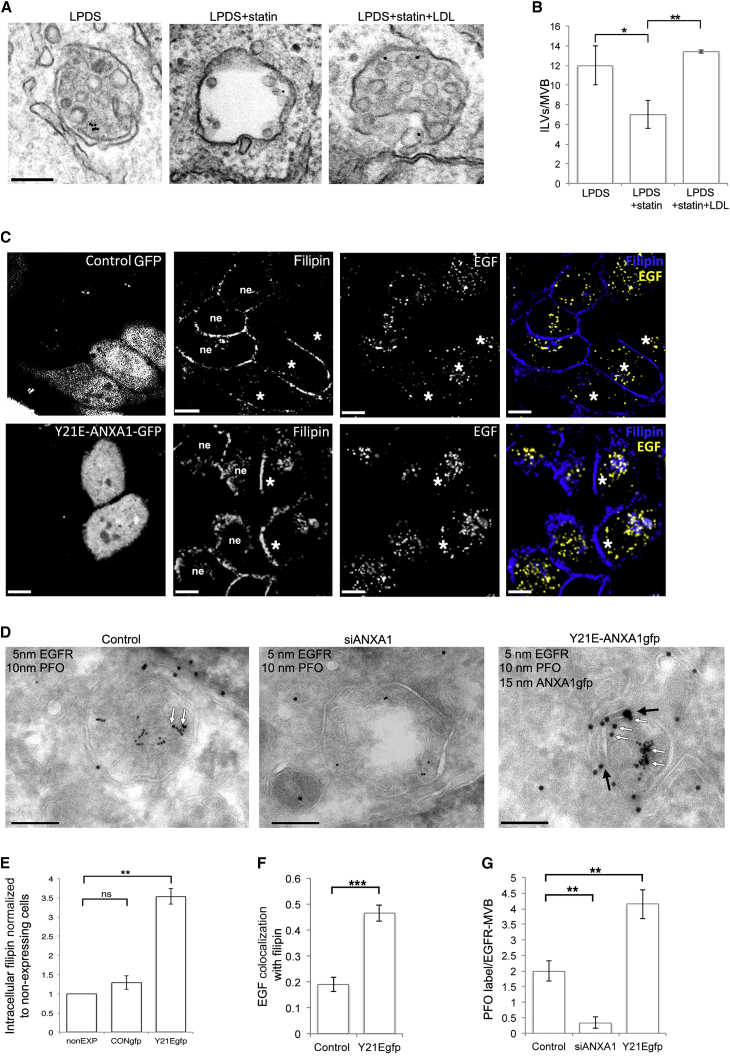
In the Absence of LDL, EGF-Stimulated ILV Formation Depends on Annexin A1-Dependent Transport of ER-Derived Cholesterol to EGFR-MVBs(A and B) HeLa cells cultured overnight in LPDS ± mevastatin (statin) ± LDL were stimulated with EGF and anti-EGFR gold for 30 min. Scale bar, 200 nm (A). ILVs/EGFR-MVB were quantified (B). Data are means ± SD of three experiments. ∗p < 0.05, ∗∗p < 0.01.(C, E, and F) HeLa cells transfected with control-GFP plasmid or phosphomimetic Y21E-ANXA1gfp were stimulated with fluorescent EGF for 30 min and filipin-stained for cholesterol. ne, non-expressing cells; ∗GFP-expressing cells. Scale bar, 5 μm (C). Intracellular filipin staining was measured in non-expressing cells (nonEXP) and cells expressing the control-GFP plasmid (CONgfp) or phosphomimetic annexin A1 (Y21Egfp) and normalized to non-expressing cells; data are means ± SD of three experiments (E). Colocalization (Mander’s coefficient) between EGF and filipin was determined in non-expressing control cells (Control) or cells expressing Y21E-annexin A1-gfp (F). Data are means ± SD of three experiments. ns, not significant p > 0.05; ∗∗p < 0.01, ∗∗∗p < 0.001.(D and G) HeLa cells transfected with Y21E-annexin A1-gfp or siRNA targeting annexin A1 (siANX) were cultured overnight in LPDS prior to stimulation with EGF and 5 nm-anti-EGFR-gold conjugate. Cryosections were labeled with PFO (10 nm) and GFP (15 nm). Black arrows indicate MCSs. White arrows show PFO label on ILVs. Scale bar, 200 nm (D). PFO gold/EGFR-MVB was quantified. Data are means ± SEM (G). ∗∗p < 0.01.See also Figure S3.